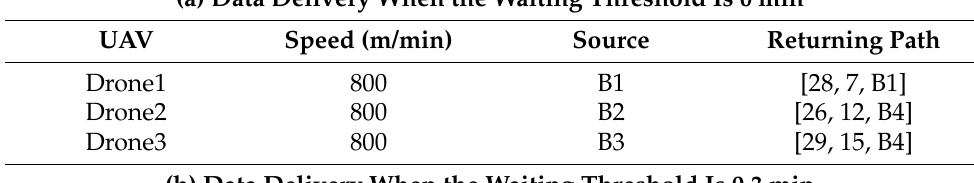
Figure 14. Visitation constrained by the waiting time. ( a ) Waiting for 0.0 min; ( b ) Waiting for 0.3 min; ( c ) Waiting for 0.5 min; ( d ) Waiting for 0.7 min. Table 8. Data delivery when the waiting threshold is small. (a) Data Delivery When the Waiting Threshold Is 0